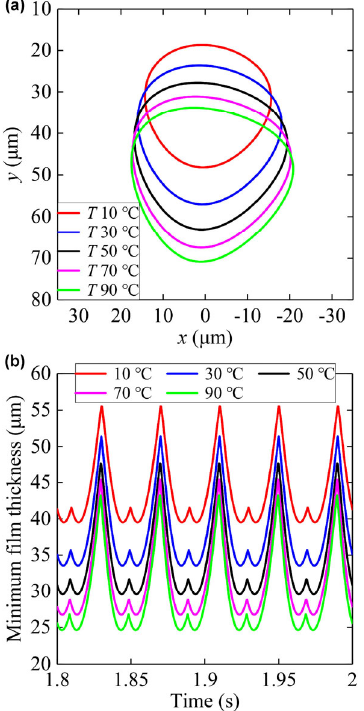
Fig. 17 (a) Journal center orbits and (b) dynamic minimum film thicknesses of a TPJB with static loads for different water temperatures.